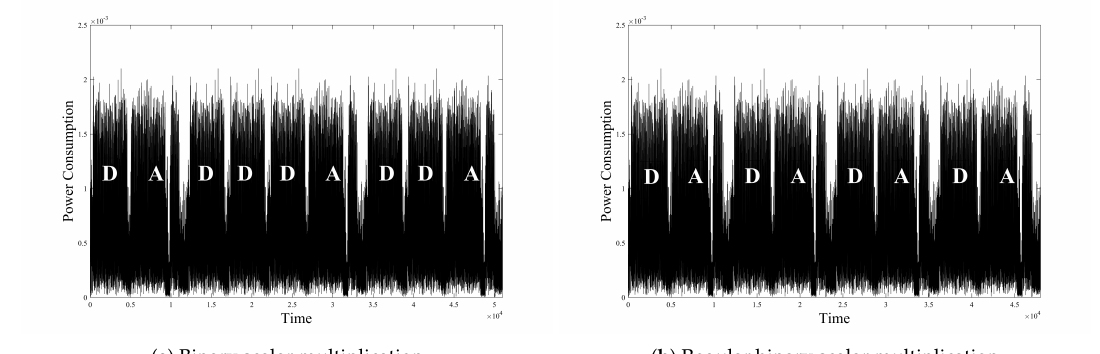
Figure 1. Power-consumption trace of binary scalar multiplication. ( a ) Binary scalar multiplication; ( b ) regular binary scalar